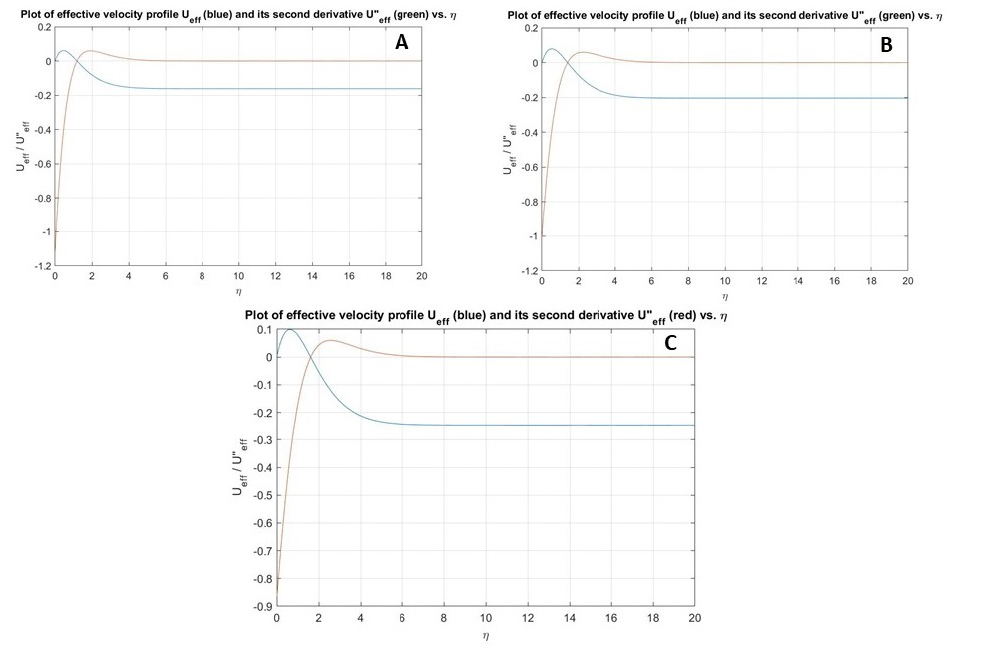
Figure 7. Plot showing the velocity effectiveness ¯¯ U (below graph at η = 20) and its second derivative ¯¯ U (cid:48)(cid:48) (above graph at η = 20) for ψ = 90 0 , T ∗ = − 0.35 ( A ), 0 ( B ) and 0.35 ( C s = 0.05 with W